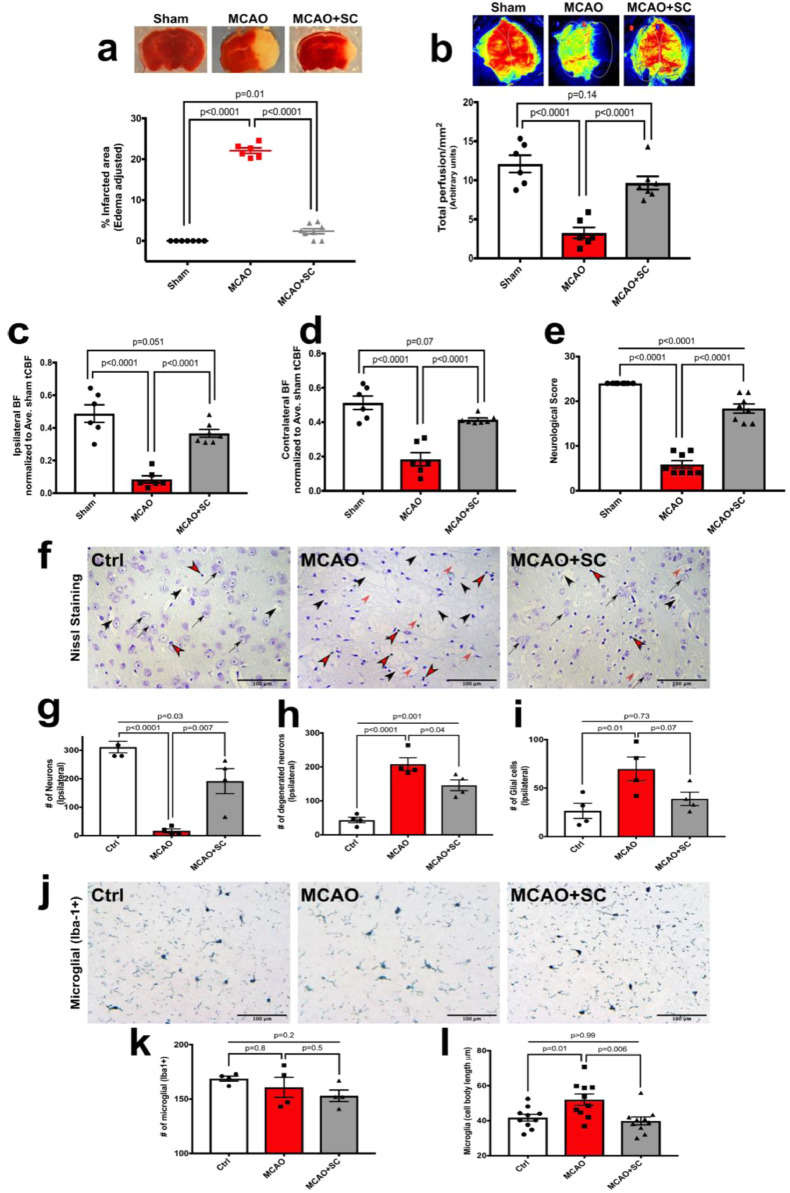
IP administration of hPMSC protects against ischemic injury in the MCAO stroke model.(a) The area of infarction (‘white’ area) in each brain slice was visualized using TTC staining and measured using Image-J (NIH). Unstained (‘white’) regions in brain slices were combined to generate a composite tissue injury score for each brain. Each point represents one animal (sham (n = 7), MCAO (n = 6), MCAO+hPMSC (n = 8)). Compared to sham, there was a significant increase in infarct size in MCAO mice (⁎⁎⁎⁎p<0.0001, one-way ANOVA). By comparison infarct size in hPMSC-treated MCAO mice was significantly reduced (⁎⁎⁎⁎p<0.0001, Student's t-test).(b) Total cerebral perfusion measured using Laser Speckle imaging. ‘Perfusion’ reflects total cerebral flow signal measured in selected tissue areas. Measurements are expressed as perfusion units (PU), using a fixed scale (arbitrary units). Significant differences were observed between cerebral perfusion in MCAO (n = 6) and sham (n = 6) mice (⁎⁎⁎⁎p<0.0001, one-way ANOVA). hPMSC-treated MCAO (n = 7) mice showed significant preservation of perfusion compared to non-treated post-MCAO group (⁎⁎⁎⁎P<0.0001, Student's t-test).(c, d) Cerebral perfusion in each pair of ipsilateral (c) and contralateral (d) brain hemispheres were normalized to the average sham total CBF as the reference point.(c) A large (83%) decrease in cerebral perfusion of the ipsilateral side of MCAO brain was observed compared to the sham operated group (⁎⁎⁎⁎p<0.0001, one-way ANOVA);(d) A significant decrease (65%) in cerebral perfusion of the contralateral hemisphere of MCAO brain was observed compared to the sham group (⁎⁎⁎⁎p<0.0001, one-way ANOVA). hPMSC treatment significantly preserved blood flow normal distribution between the hemispheres (far right bars; c, d); significant differences determined by Student's t-test, ⁎⁎⁎⁎p<0.0001 and ⁎⁎⁎⁎p<0.0001 for comparison of hPMSC-treated MCAO mice to untreated MCAO ipsilateral (c) / contralateral (d) hemispheres, respectively.(e) Neurological scores 24 h post-reperfusion. Significant differences in neurological scores were seen between untreated MCAO (n = 8) and hPMSC-treated MCAO (n = 8) to sham (n = 8) group (⁎⁎⁎⁎p<0.0001, one-way ANOVA). There was a significant improvement in neurological score in hPMSC-treated MCAO mice compared to untreated MCAO (⁎⁎⁎⁎p<0.0001, Student's t-test).(f) Neuronal degeneration in MCAO with hPMSC therapy. Neurons (black arrows), degenerating neurons (black arrows head), glial cells (red arrows head), and spongiform regions (red arrows) were visualized using Nissl staining of brain sections in untreated and hPMSC-treated MCAO groups.Two-tailed Student's t-test analysis revealed significant differences in proportions of (g) neurons (*p = 0.02), (h) degenerating neurons (*p = 0.04), and (i) glial cell (*p = 0.02) numbers in hPMSC-treated MCAO brain sections compared to untreated MCAO sections. In all graphs, data represent means ± SEM. (j) Representative images after immunohistochemistry staining for Iba-1.(h) Quantification of numbers of Iba-1+ microglia in the border between striatum and cortex (average of 3 different fields) of ipsilateral hemisphere of MCAO and MCAO+hPMSC groups (NS, p = 0.5, Student's t-test, n = 4 per group).(i) Microglial activation in ipsilateral hemispheres of MCAO and MCAO+hPMSC groups was determined by cell body length (⁎⁎p = 0.002, Student's t-test). (For interpretation of the references to color in this figure legend, the reader is referred to the web version of this article.)